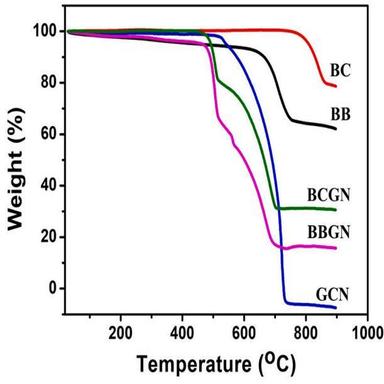
TGA curve of (a) BB, (b) BC, (c) GCN, (d) BBGN and (e) BCGN nanocomposites.